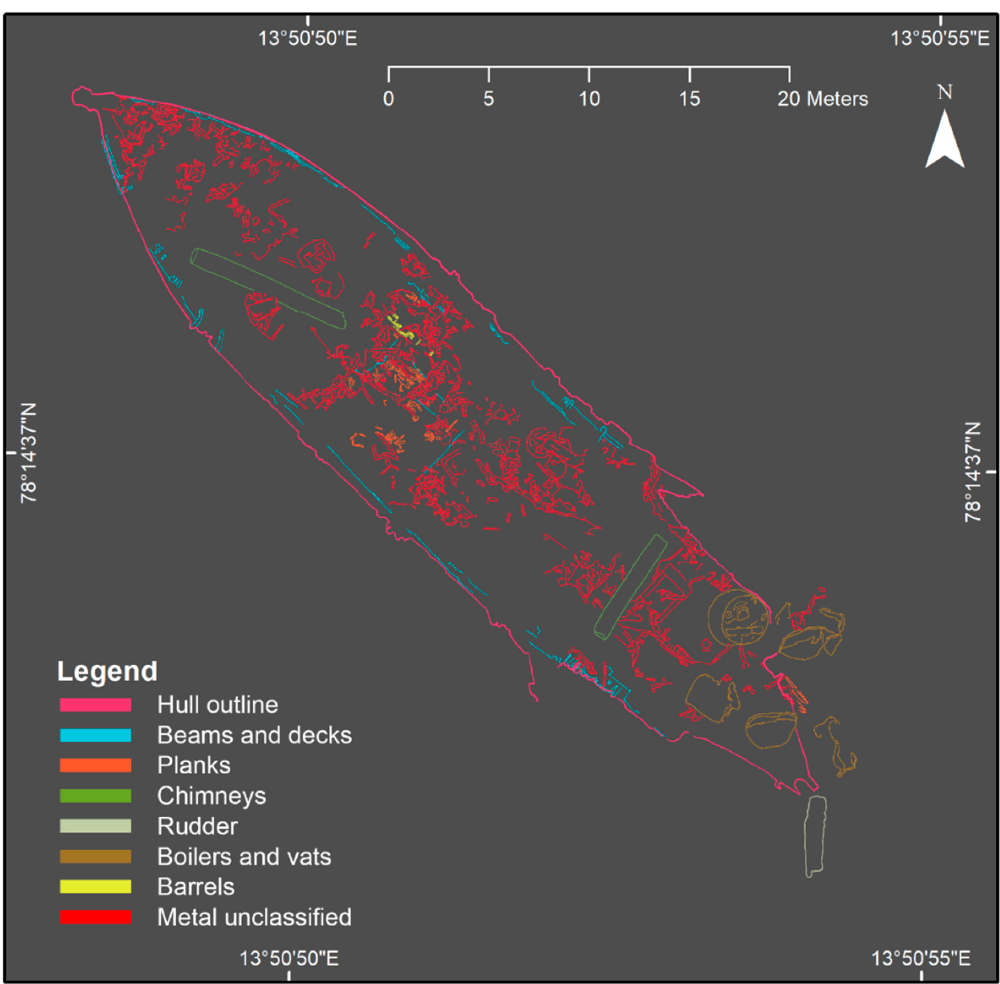
Figure 9. Site plan of the Figaro wreck based on the photogrammetry 3D model, stereo camera still images and high-definition (HD) video. The figure was generated in ArcMap (v. 10.6; Esri Inc., Redlands, USA; http://desktop.arcgis.com/en/arcmap/). Projection: UTM 33, Datum: WGS 1984.